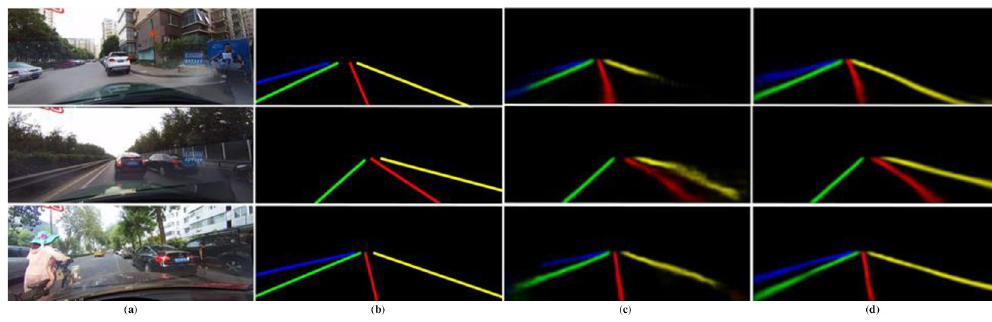
Fig 9. Comparison of GAAN and SCNN, ( a ) Input; ( b ) GT; ( c ) SCNN; ( d ) GAAN.